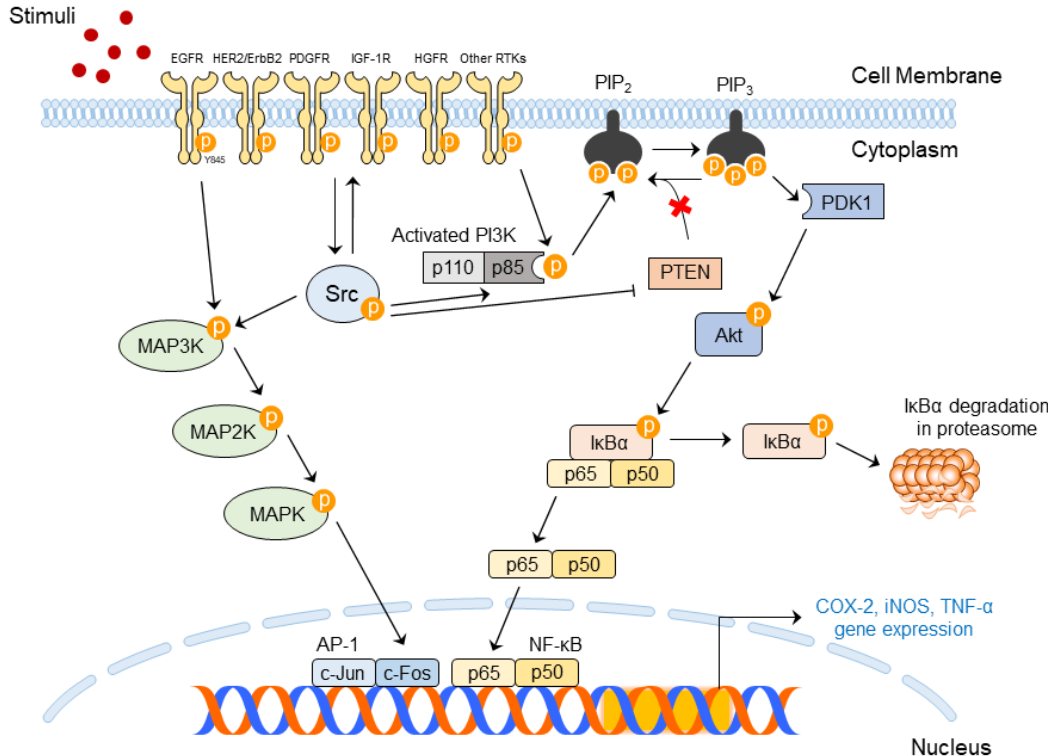
Figure 2. Src signaling pathways in skin inflammation and skin cancer.